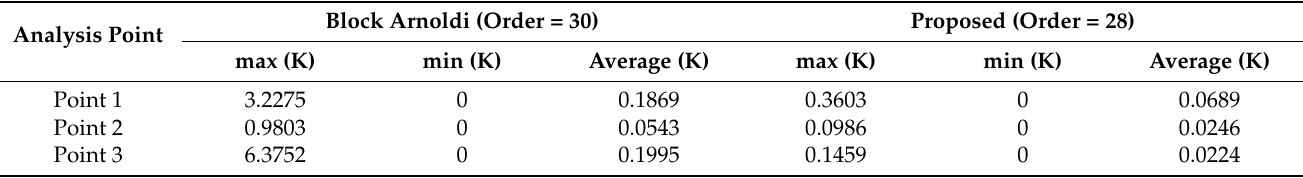
Table 2. Comparisons of the absolute errors on different observing points by using the proposed and conventional schemes.